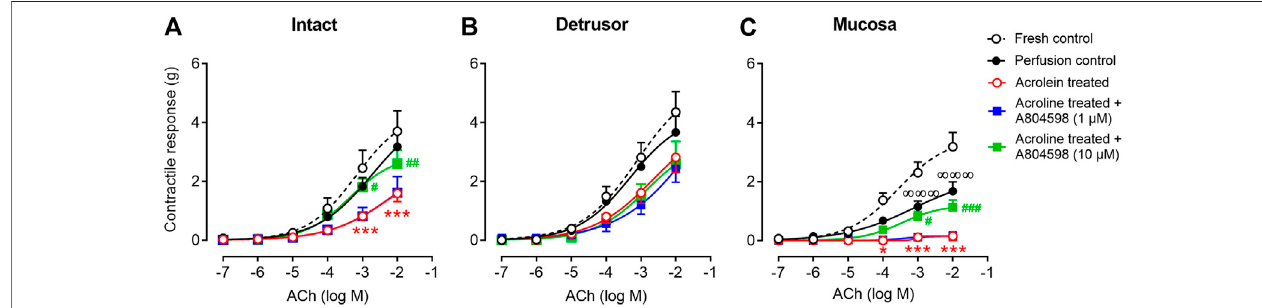
FIGURE 4 | The contractile responses of the porcine bladder strips to ACh. (A) Intact strips (containing the entire layer of the bladder wall). (B) Detrusor muscle strips. (C) Mucosalstrips(containingtheurotheliumandthelaminapropria).ThecontractileresponsestoAChweresimilarinthefreshcontrolandtheperfusioncontrolin both the intact (A) and detrusor (B) strips, but the ACh-induced contraction was reduced in the mucosal strips of the perfusion control (C) . In the acrolein-treated bladders,thecontractileresponsestoAChweresigni fi cantlydiminishedintheintactstripsandcompletelyabolishedinthemucosalstripsbutwereslightlyreduced in the detrusor strips. Pre-treating bladders with the P2X7 receptor antagonist A804598 at 1 µM showed no effect but at 10 µM signi fi cantly reversed acrolein-induced reduction in response to ACh in the intact and mucosal strips. The data are shown as mean ± SEM from n (cid:2) 6 – 11 bladders for each group and analyzed by two-way ANOVA, followed by Bonferroni test ( ∞∞∞ p < 0.001, compared to the fresh control group; * p < 0.05 and *** p < 0.001, compared to perfusion control; # p < 0.05, ## p < 0.01, and ### p < 0.001, compared to the acrolein-perfused group).